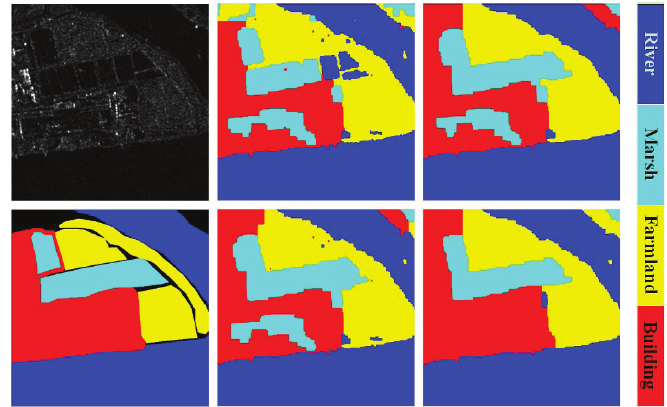
Figure 10. Classifications of localized area ( top , left–right: SAR image, result from GAM + MRF, result from AS + MRF; bottom , left–right: Visually interpreted map, result from MGAM + MRF, result from MAS +